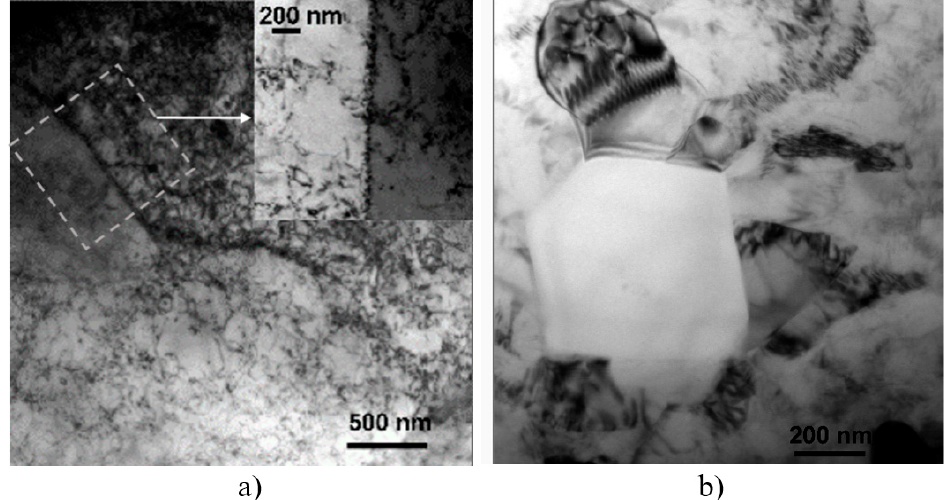
Figure 7. ( a ) Dislocation wall formation, and ( b ) subgrain formation, within the NZ of the A-FSW 2 - CR condition.